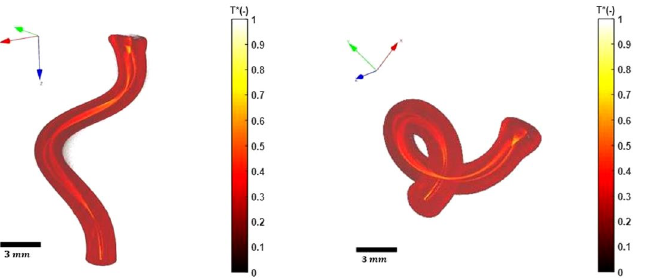
Figure 7. Dimensionless reconstructed three-dimensional proper emission maps of the PFA tubing filled with water and ethanol. (Created with MATLAB 2020a, https ://mathw